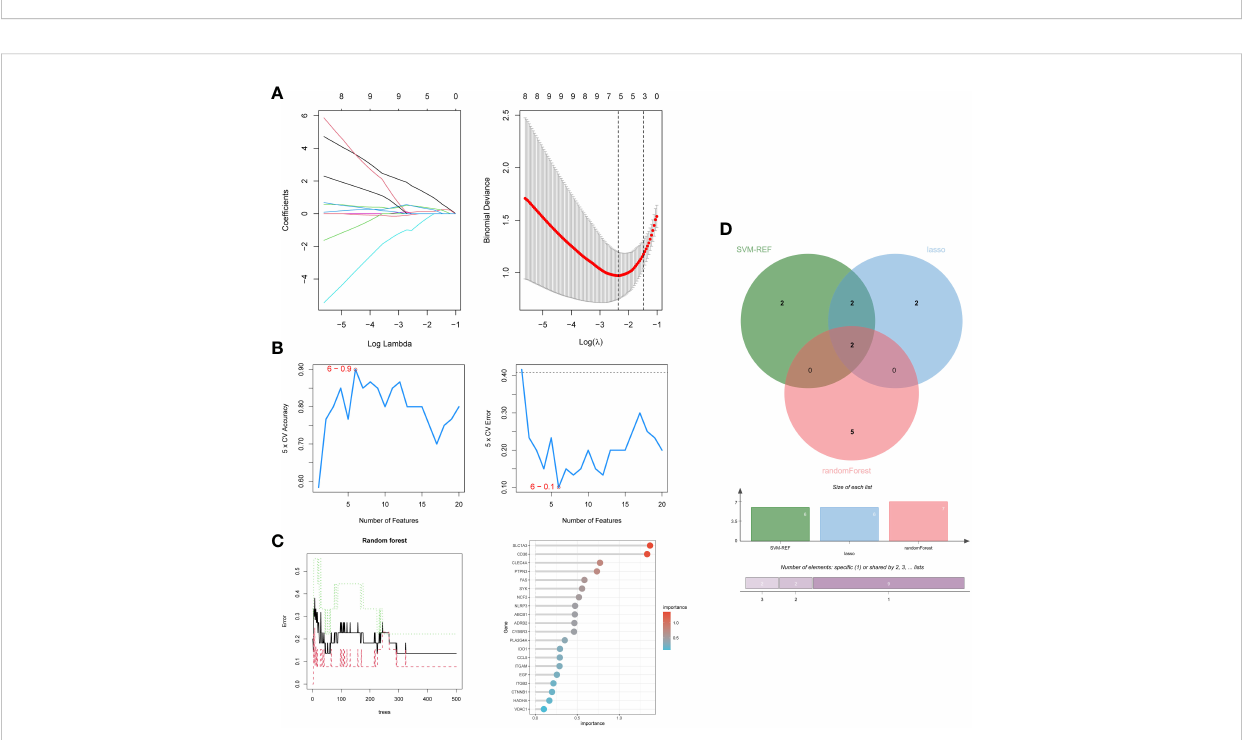
FIGURE 5 Screening hub genes by machine learning. (A) LASSO regression algorithm. (B) SVM-RFE algorithm. (C) RF algorithm. (D) Venn diagrams for three algorithms. LASSO, Least Absolute Shrinkage and Selection Operator; SVM-RFE, Support Vector Machine-Recursive Feature Elimination; RF, Random